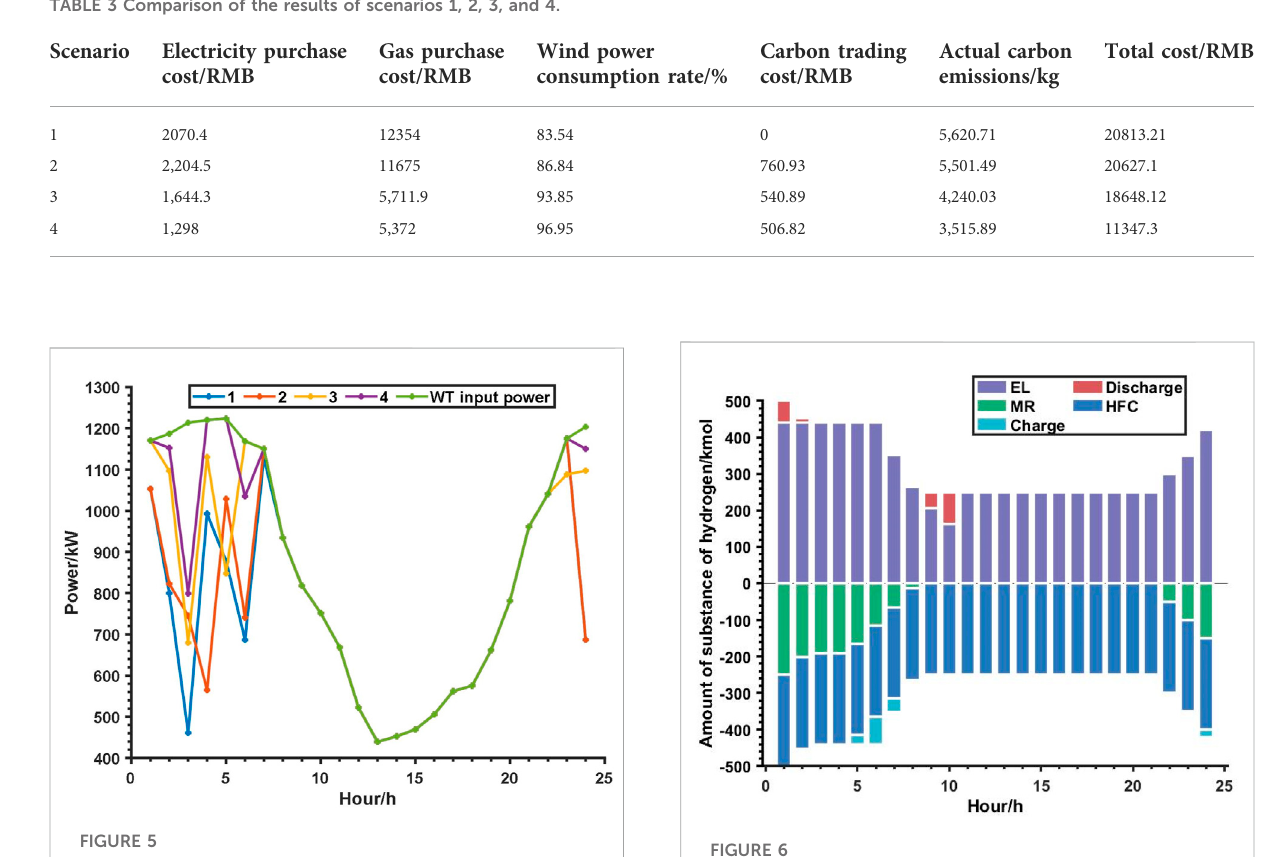
FIGURE 6 Hydrogen power balance diagram for scenario